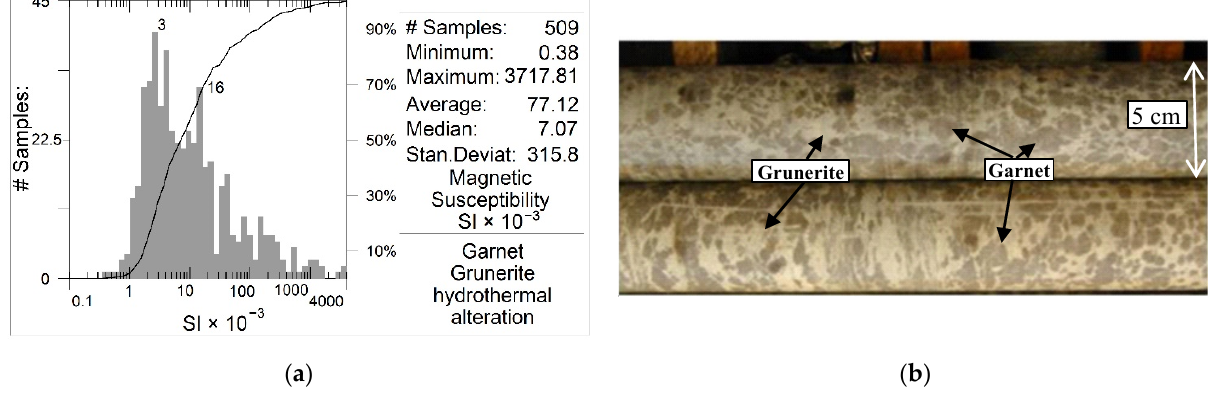
Figure 14. Garnet-grunerite (Ca) hydrothermal alteration zone. ( a ) Statistics and histograms of the magnetic susceptibility measurements. ( b ) Core samples picture.